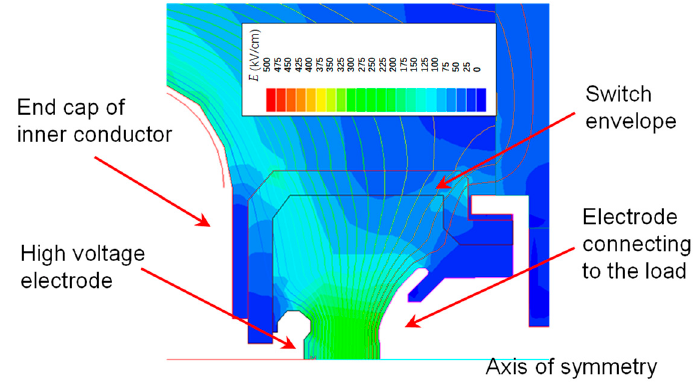
Figure 10. Output switch field distribution.